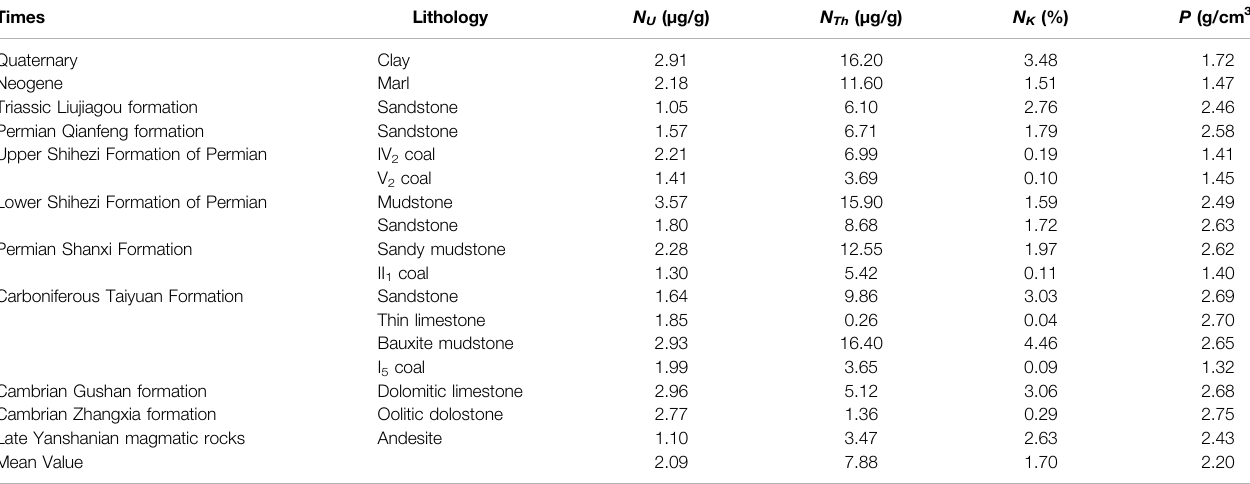
TABLE 3 | Measured contents of radionuclides in the different strata.